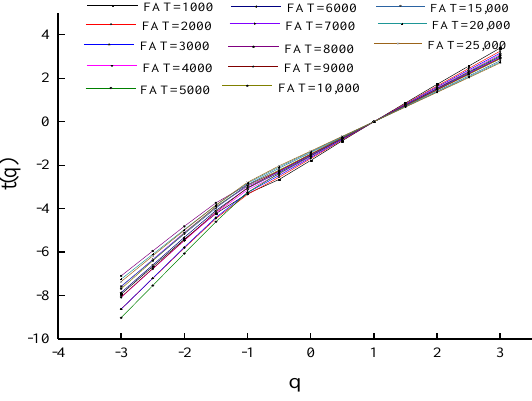
Figure 7. τ (q) vs. q functions corresponding to FAT values (Hubei Province).